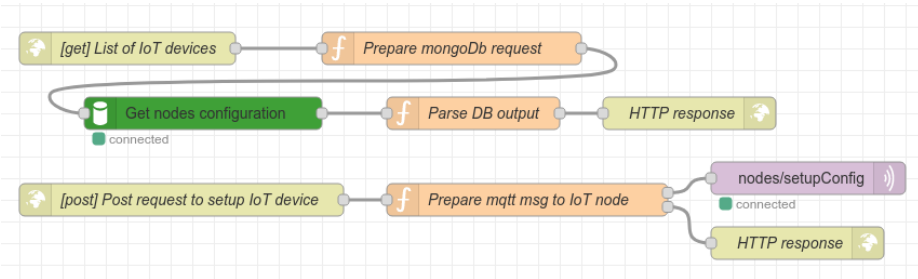
Figure 9. Schematic design of flow for providing the RESTful API for setting up the IoT